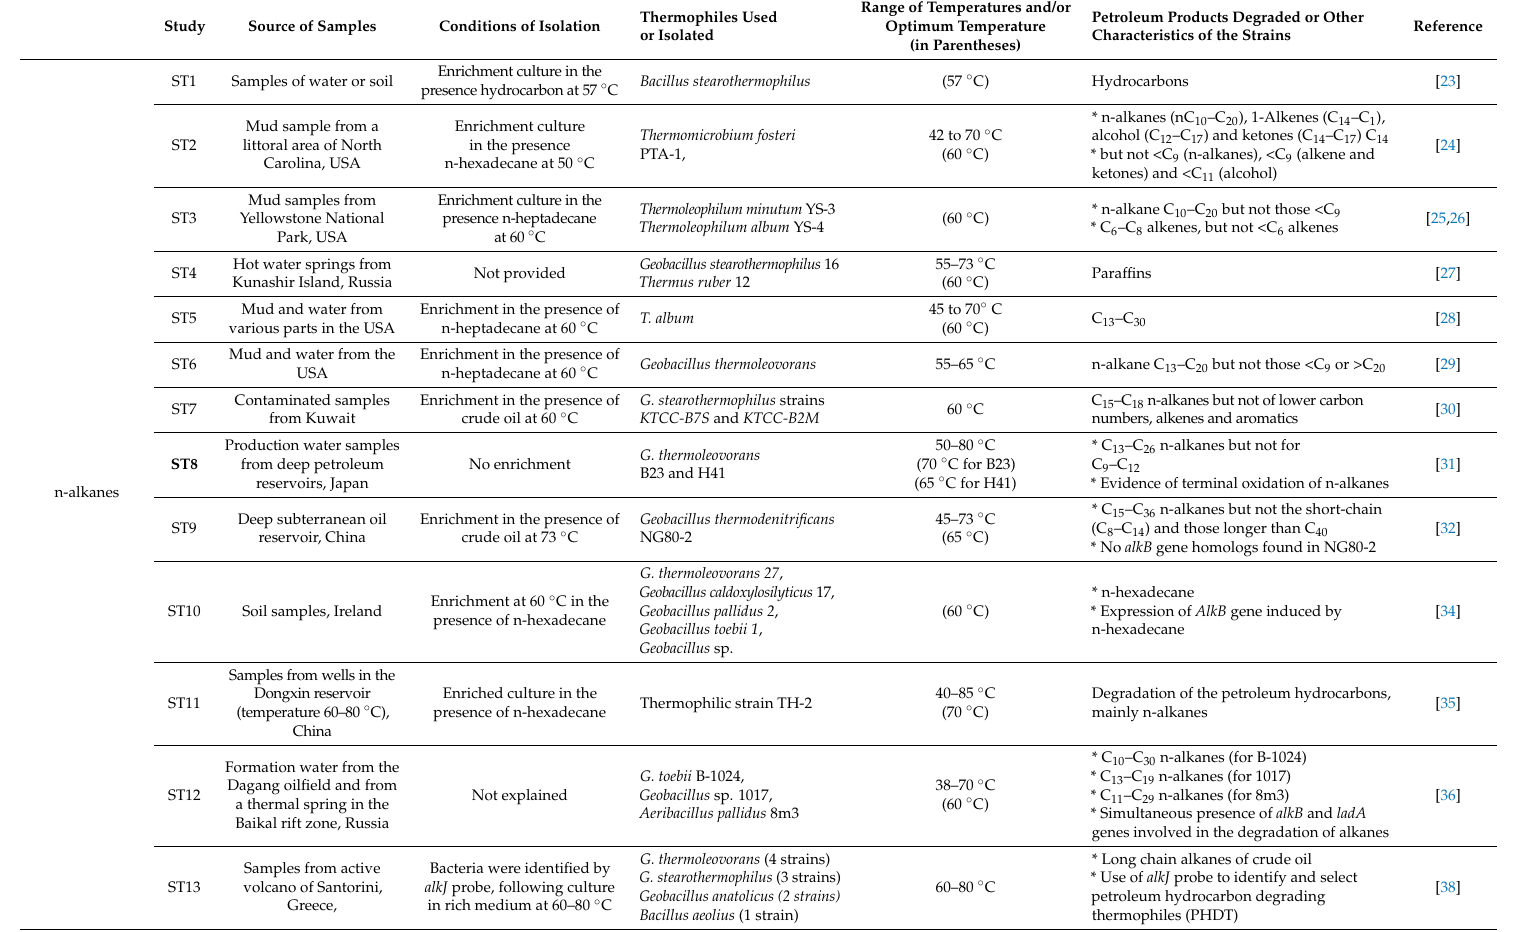
Table 1. Summary of studies on biodegradation of petroleum products by thermophilic